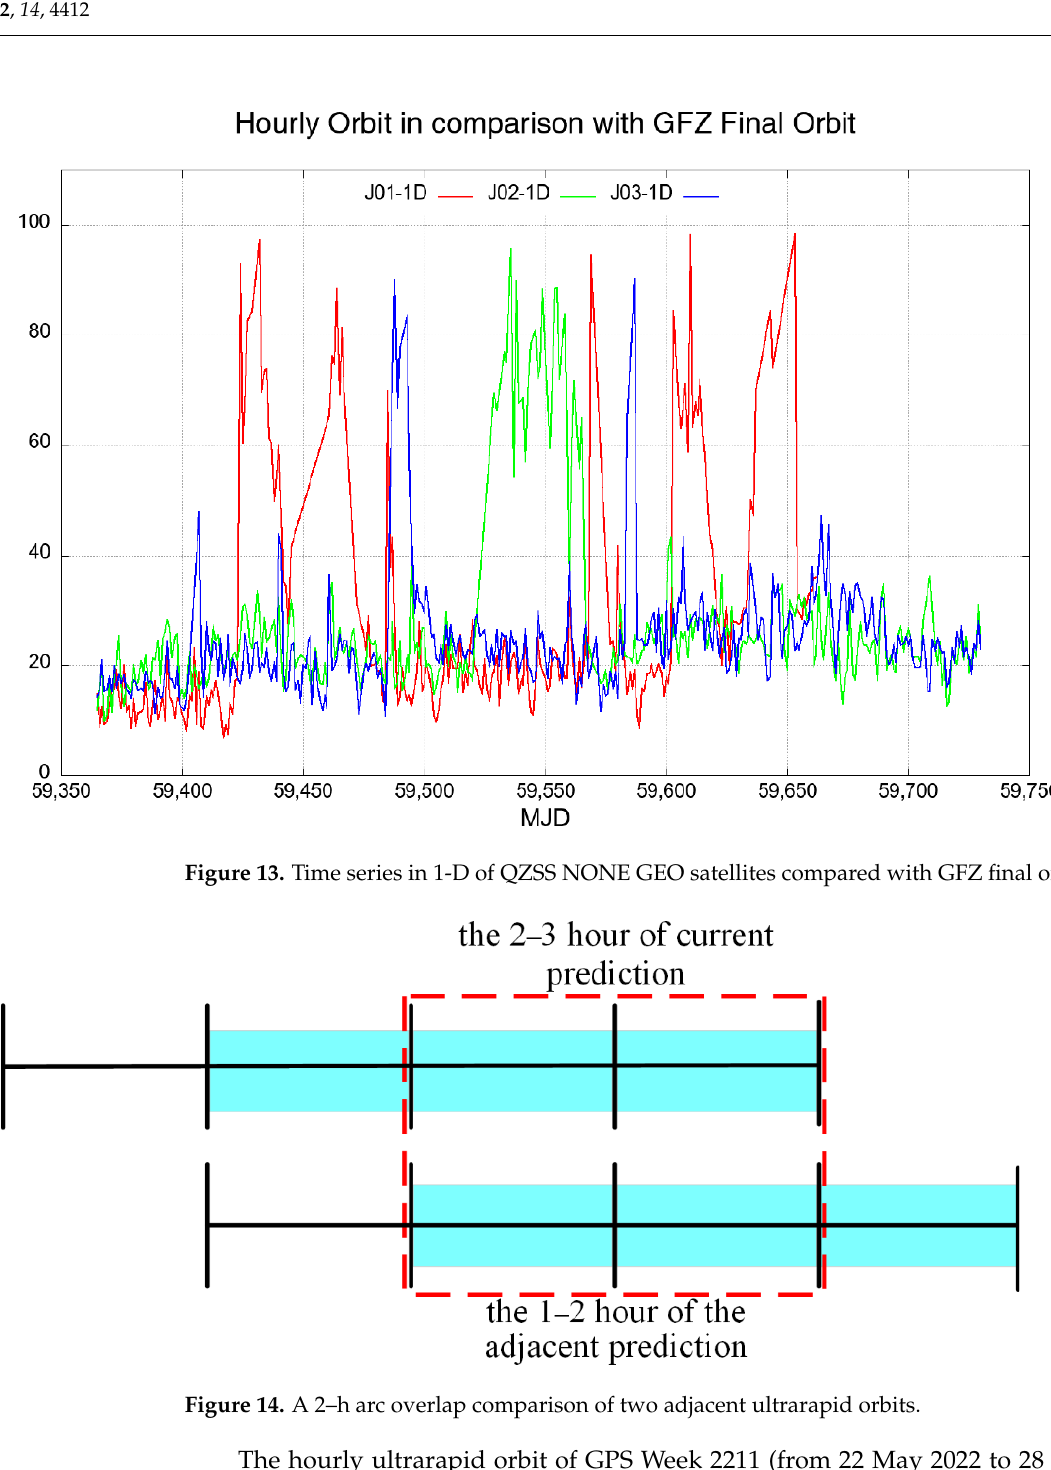
Figure 14. A 2–h arc overlap comparison of two adjacent ultrarapid orbits.